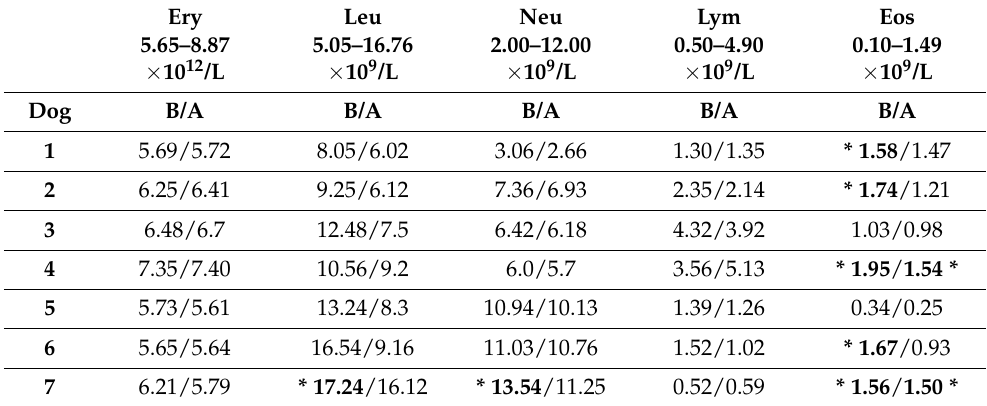
Table 6. Hematological analysis before (B) and after (A) therapy in the second group of patients.